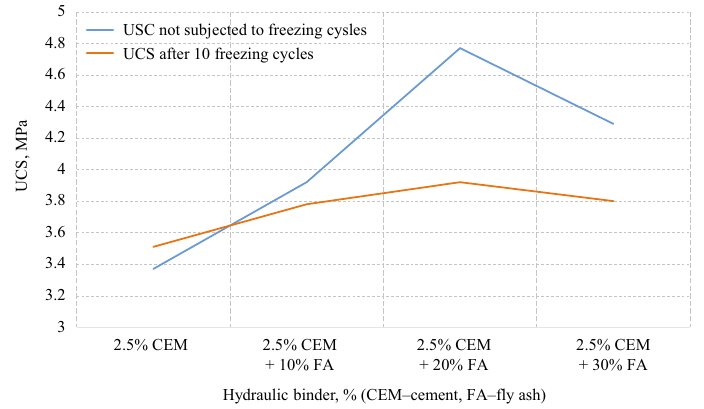
Note: samples with 2.5% cement in the composition. Figure 6. Unconfined compression strength for reference samples and after ten freezing cycles